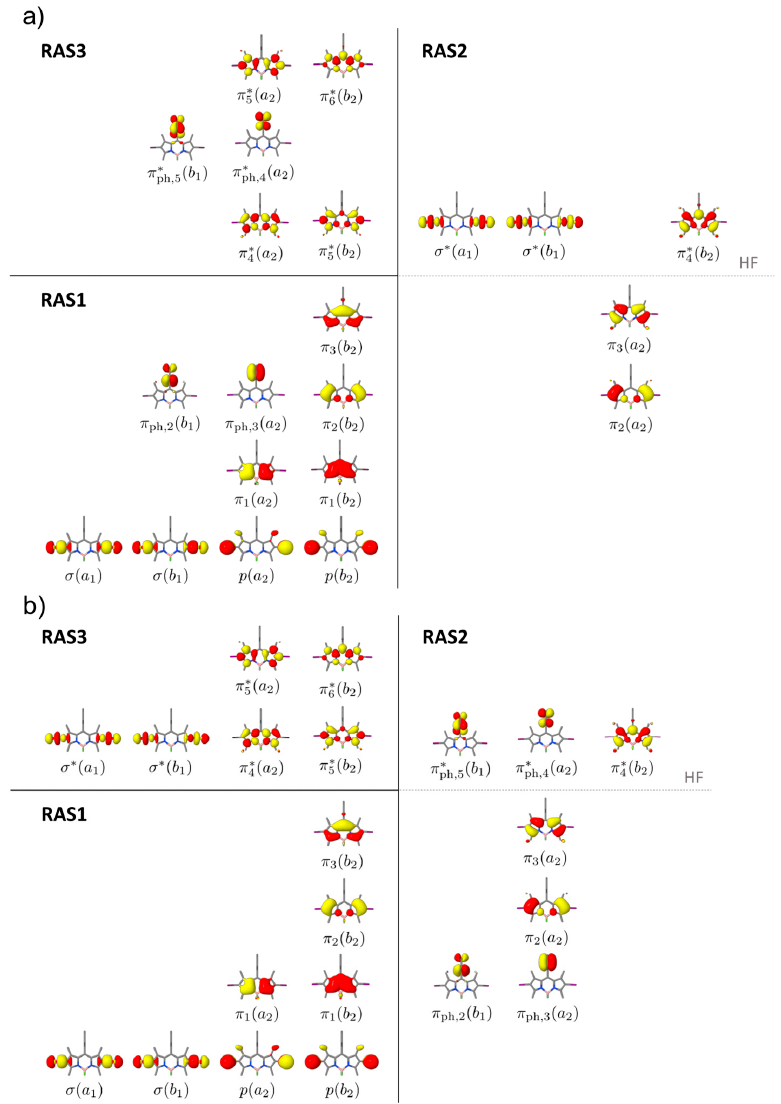
Figure 5. ( a ) RAS diss (21,2,2;10,5,6) and ( b ) RAS CT (21,2,2;8,7,6) to describe ground, bright, and dissociative or CT-excited states for both mechanisms within their C 2v optimized ground state (PBE0/cc-pvdz) structure ( 1 1 0 and 2 1 − 1 ). The distribution over the subspaces RAS1, RAS2, and RAS3 is displayed, the occupation within the Hartree-Fock (HF) reference wave function is indicated by the gray dashed line. State-average (SA-)RASSCF calculations including the first four roots in each spatial symmetry and multiplicity were carried out using both RASs in the 1 1 0 and 2 1 − 1 geometry. Dynamical correlation was added my means of multistate (MS-)RASPT2 [73] on the SA-RASSCF reference wave functions, while the core electrons were kept frozen and a real level shift [74] of 0.3 a.u. was applied to prevent intruder states.